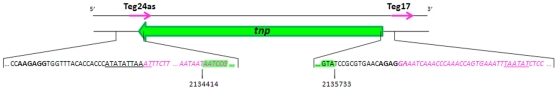
Schematic representation of antisense transcripts in the tnp region.Among the transposases annotated in the genome of S. aureus N315, antisense RNAs were identified 8 times at the extremities of the tnp transcripts, suggesting an important functional role. This example shows Teg24as and Teg17 (pink italic font) and their complementary tnp gene (green). In the sequences detailed below, the potential promoter sequences are underlined and the potential Shine-Dalgarno sequences appear in bold fonts.